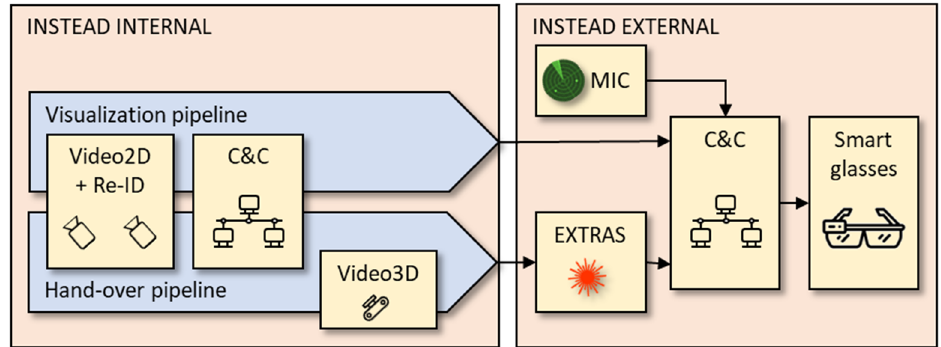
Figure 13. Two INSTEAD pipelines: visualization and hand ‐ over.